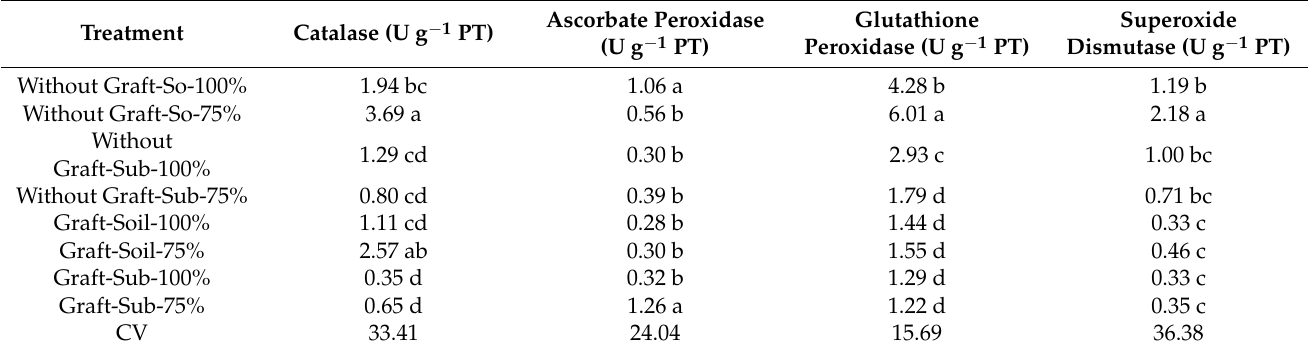
Table 4. Comparison of means for the treatments in enzymatic activity of the